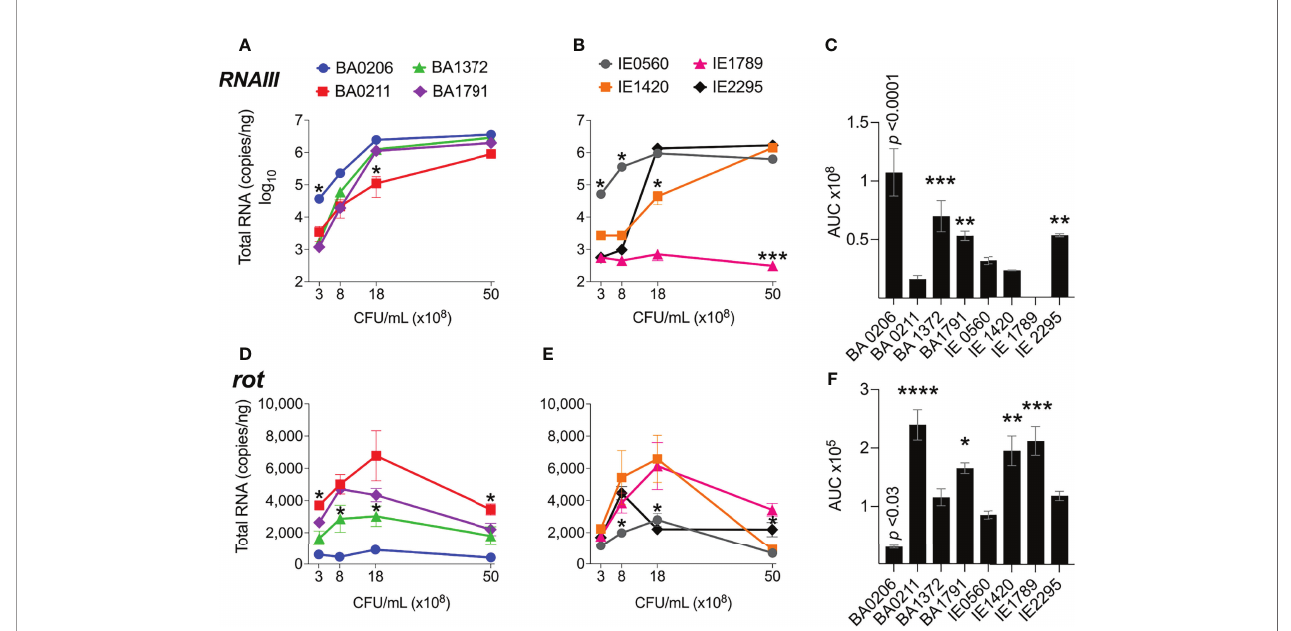
FIGURE 3 | RNAIII and rot expression in S. aureus CC5 isolates. Quantitation of S. aureus CC5 gene expression during growth in TH broth by RT-qPCR standard curve quantitation method. (A, B) RNAIII expression and (D, E) rot expression at indicated cell densities. Error bars (standard deviation) not shown are smaller than symbol. Asterisks indicate data points signi fi cantly different than the rest at that speci fi c cell density. (C, F) Area under the curve (mean ± SEM). Data is the result of three biological replicates. *, p < 0.05, **, p < 0.005, ***, p < 0.0005, ****, p < 0.0001, one-way ANOVA with Holm-S ̌ ı ́ da ́ k ’ s multiple comparisons test across